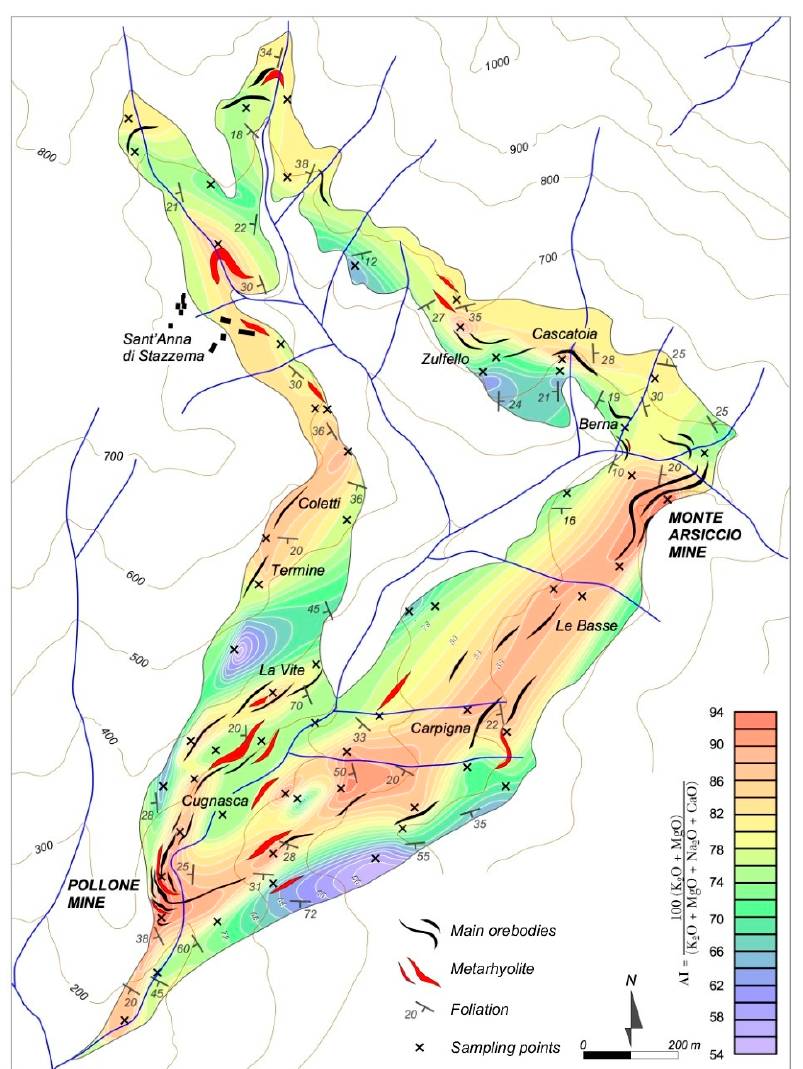
Figure 10. Sant’Anna tectonic window AI distribution map (see text for further details) based on geochemical data from “Filladi Inferiori” Fm. The main ores and Fornovolasco Metarhyolites bodies are also reported.